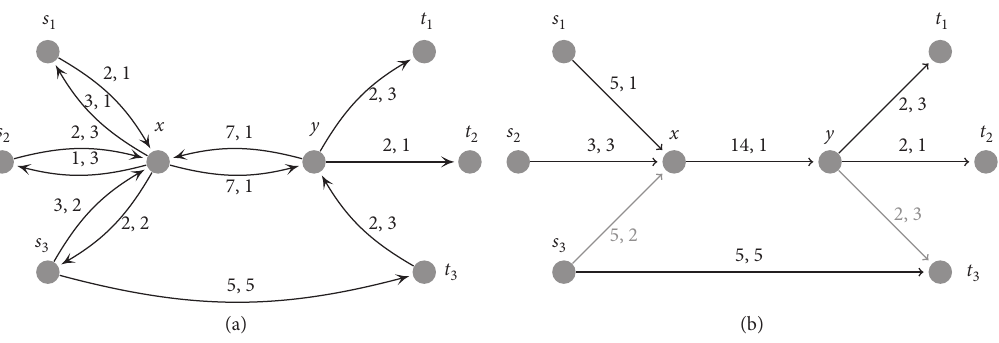
Figure 3: (a) Network with uniform path length before lane reversals (capacity, transit time). (b) Lane reversal network of (a) violating uniform path length (capacity, transit